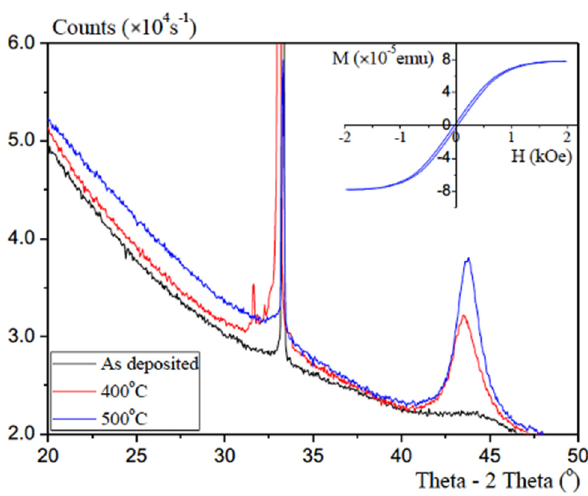
Figure 6. Representative XRD patterns of the Ni 2 MnAl thin films doped with one Co peg as depos- ited and after two hours of annealing at 400 and 500 °C. The inset shows the corresponding mag- netisation loop of the latter film. Note that the silicon substrate (200) peak and the fringes are visible at